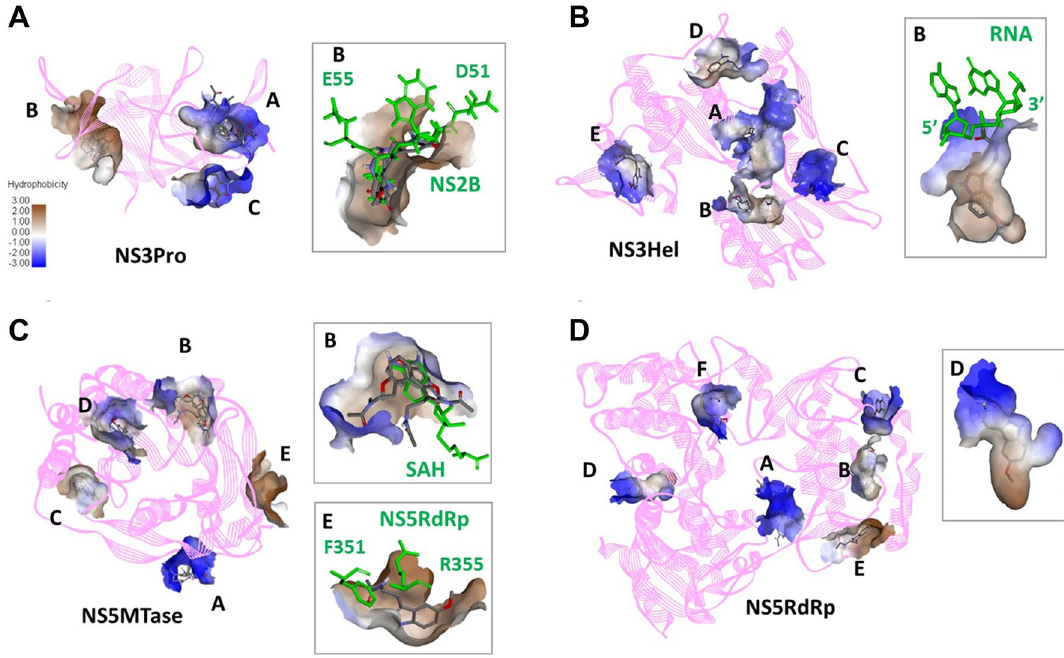
Figure 5. Molecular docking of melatonin with the JEV replicational enzymes NS3Pro, NS3Hel, NS5Hel, and NS5RdRp. The interaction areas of each enzyme with melatonin are indicated as regions A to F. The hydrophobicity value of the melatonin binding region reported in Table 2 is illustrated as a color spectrum. Gray indicates a positive hydrophobicity value, while blue indicates a negative hydrophobicity value. The right panels depict the superimposition of melatonin and the specific ligand with each enzyme. ( A ) The melatonin-docked NS3Pro superimposed on NS3Pro-NS2B (PDB ID: 4R8T). A detailed comparison of the docked melatonin ligands and NS2B is depicted in the zoomed view to the right. ( B ) The superposition of melatonin-docked NS3Hel with DENV RNA-NS3Hel (PDB ID: 2JLY 97 ). An enlarged view of the docked melatonin and RNA (2GA3) is shown on the right. ( C ) The superimposition of NS5MTase with docked melatonin ligands and NS5MTase-SAH (PDB ID: 4K6M). Coordinate comparisons for melatonin ligands with SAH and NS5RdRp residues are explained in the right panels. ( D ) The docked melatonin on NS5RdRp. The images were produced using BIOVIA. (https:// www. 3ds. com/ produ cts- servi ces/